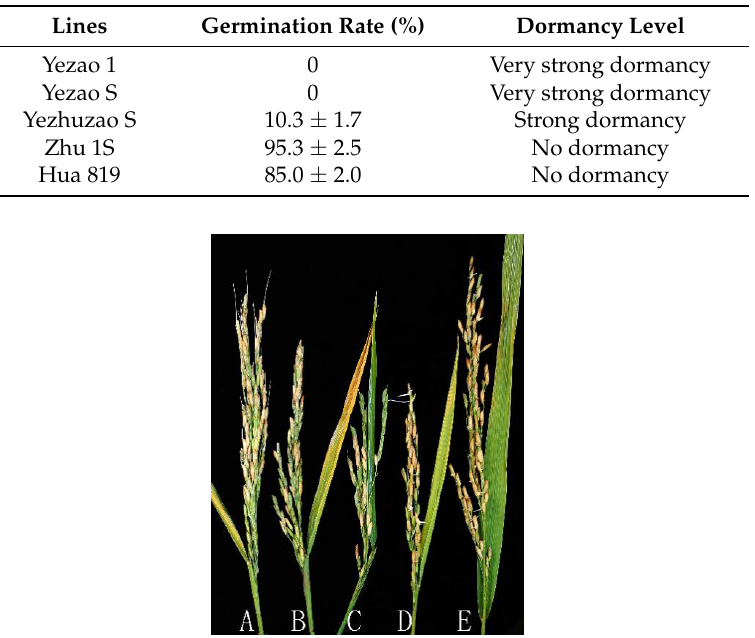
Figure 1. Comparison of PHS in different rice lines. A. Yezao 1; B. Yezao S; C. Yezhuzao S; D. Zhu 1S; E. Hua 819.